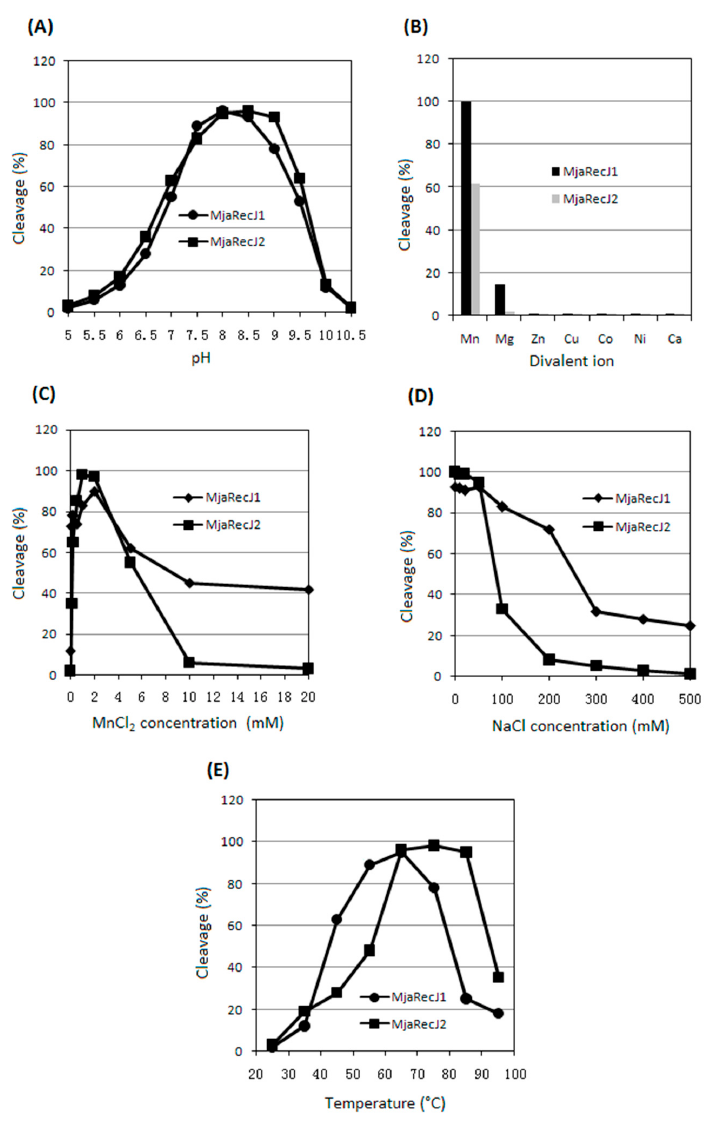
Figure 2. Optimization of ssDNA hydrolysis by MjaRecJs. pH value ( A ), divalent ions ( B ), concentration of divalent manganese ions ( C ), ion strength ( D ), and reaction temperature ( E ) were optimized for nuclease activities of two MjaRecJs (40 nM MjaRecJ1 or 50 nM MjaRecJ2) using a 23 nt single-stranded DNA (ssDNA) as substrate (200 nM). The degraded amount of substrate DNA was quantified and plotted vs. each value.